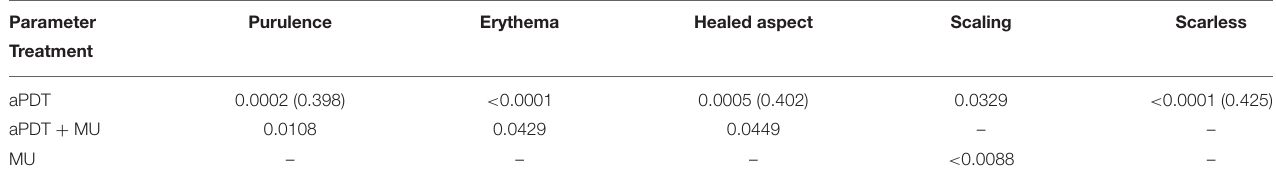
Chi Square/Fisher Exact p-value. (Table shows only significative V Cramer: v > 0.3). aPDT, antimicrobial photodynamic therapy; MU, mupirocin.